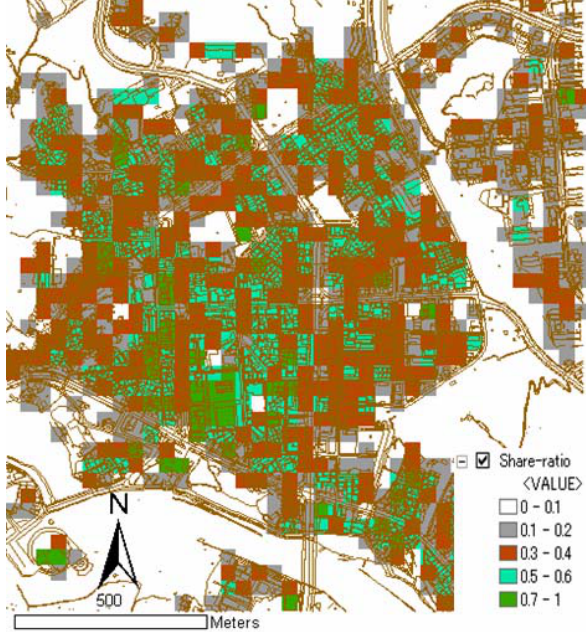
Fig. 3. Share rate of building per unit grid with contour